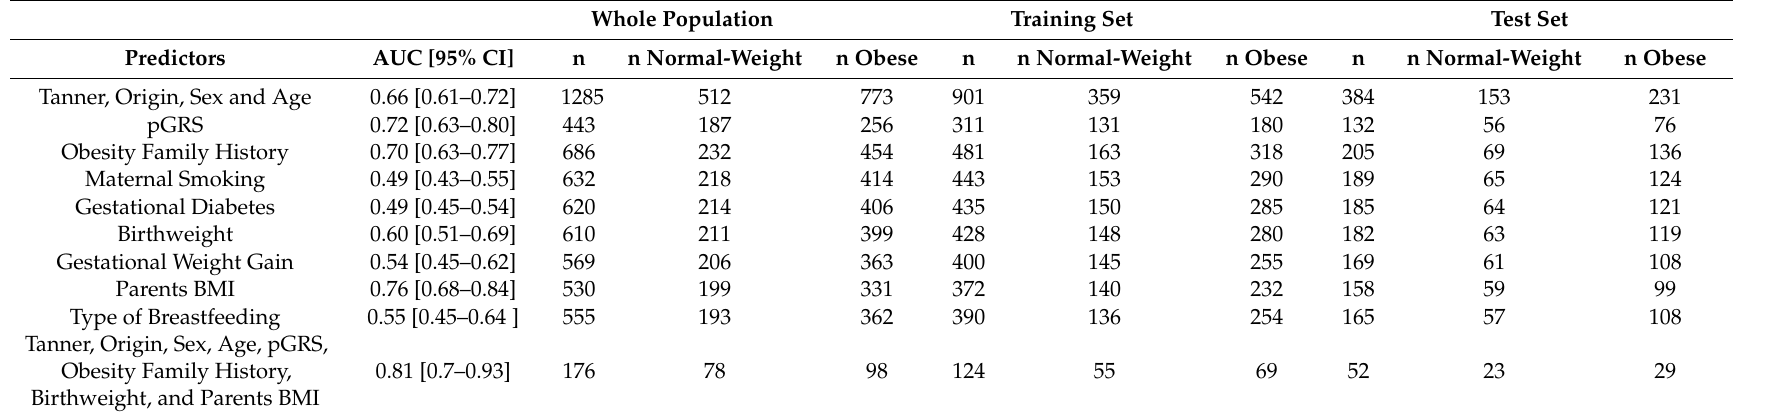
Table 1. Obesity predictive ability for assessed traditional and genetics risk factors in the study population 1. Whole Population Training Set Test Set Predictors AUC [95%